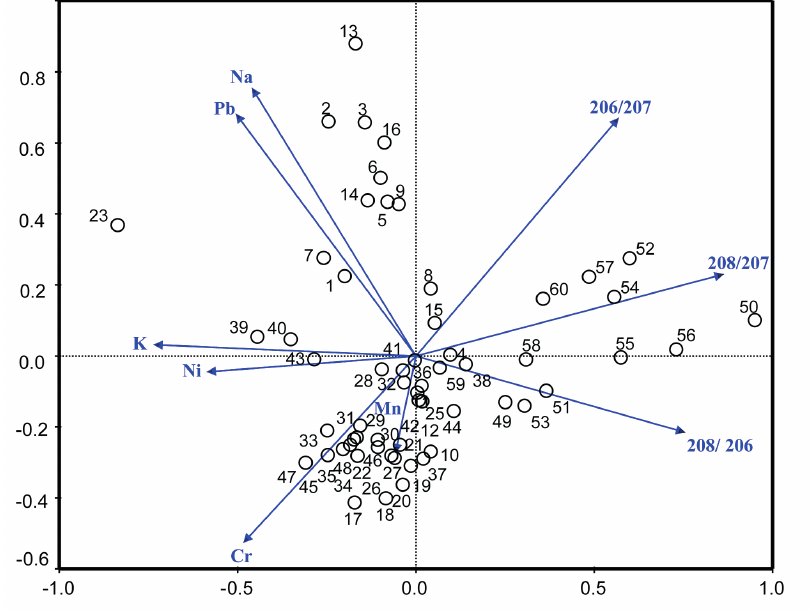
Figure 5 - PCA plot for metallic elements and isotope ratios of Parmotrema crinitum (Ach.) from four sampling sites in Rio de Janeiro